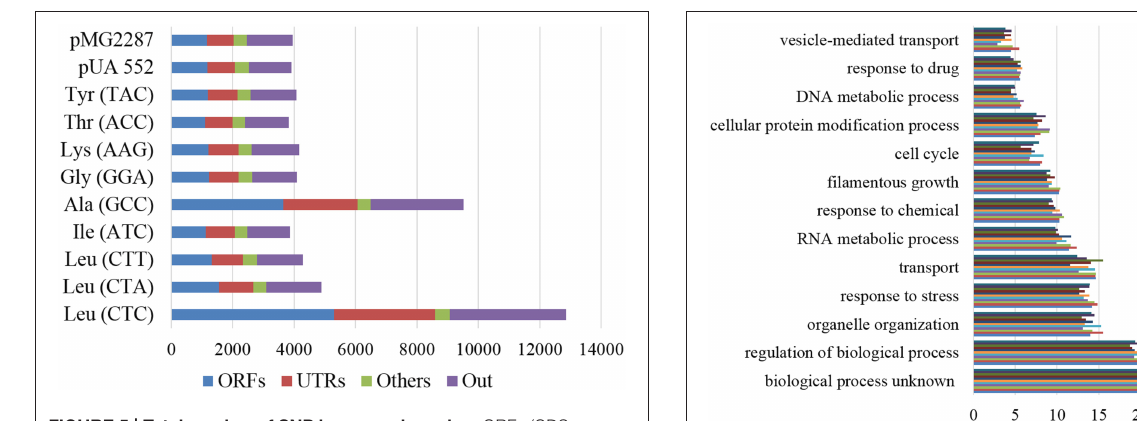
FIGURE 5 | Total number of SNP by genomic region. ORFs (CDS, snoRNA, ncRNA, tRNA, and rRNA); Others (repeat-region, long-terminal repeat, retrotransposon, and centromeres); UTRs (blocked reading frame, snRNA, noncoding exon, and pseudogenes, 3 ′ UTR e 5 ′ UTR) and Out (regions not defined in ORFs, Others and UTRs). The data compares evolved and non-evolved strains. FIGURE 6 | Gene ontology process terms. All genes affected by SNPs